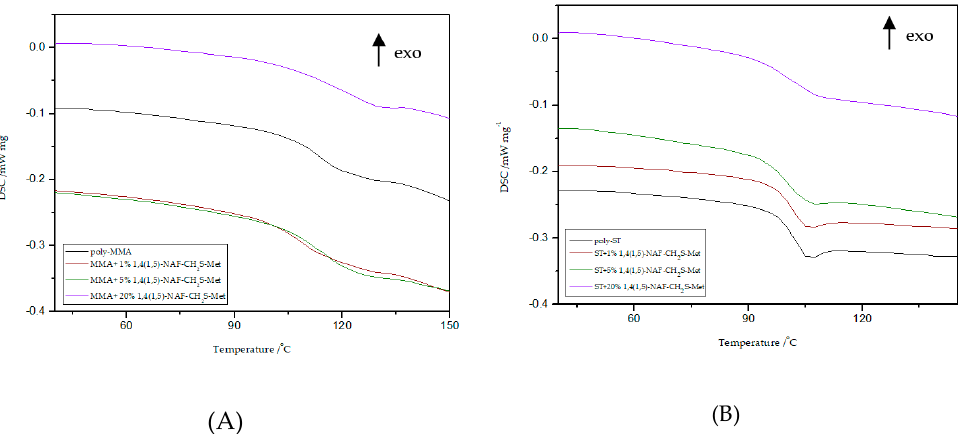
Figure 8. Influence of various addition of 1,4(1,5)-NAF-CH 2 S-Met on the T g values of MMA- ( A ) or ST- based ( B ) polymers.